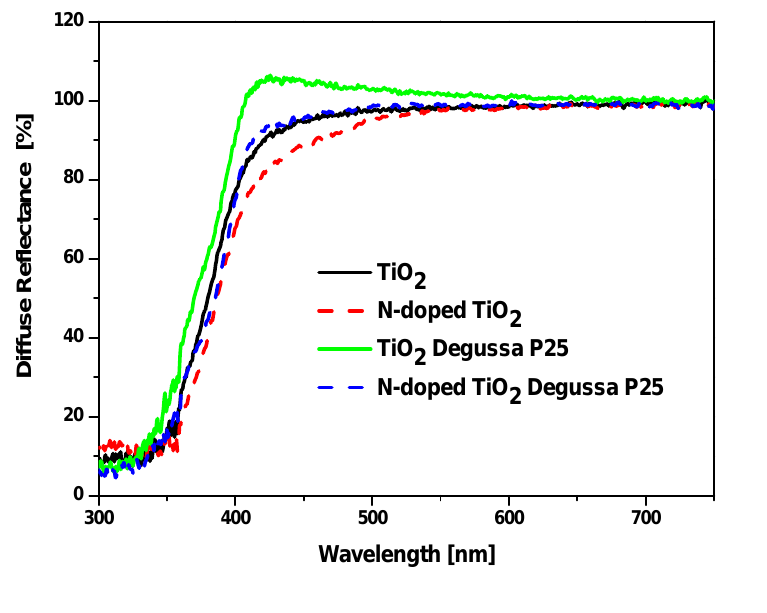
Figure 3. UV-Vis diffuse reflectance spectra of undoped and urea-modified TiO